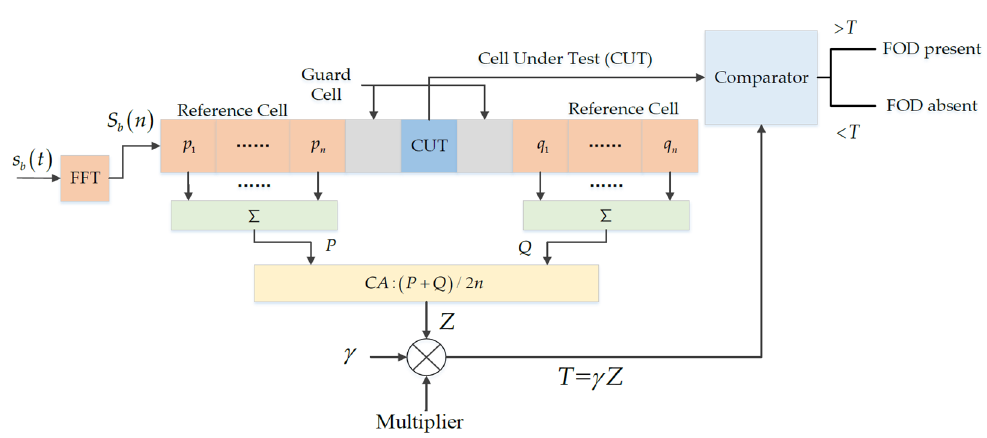
Figure 1. Basic principle of the cell average constant false alarm rate (CA-CFAR) detector. FFT: Fast Fourier Transform, FOD: Foreign Object Debris.